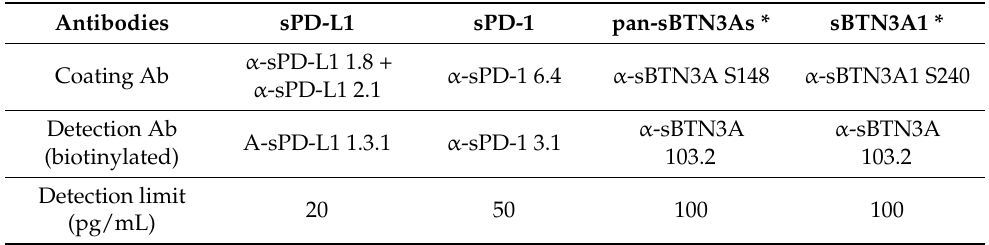
Table 4. Characteristics of ELISAs for sPD-1, sPD-L1, sBTN3 A1, and pan-sBTN3 As. Antibodies sPD-L1 sPD-1 pan-sBTN3As * sBTN3A1 * Coating Ab Detection Ab